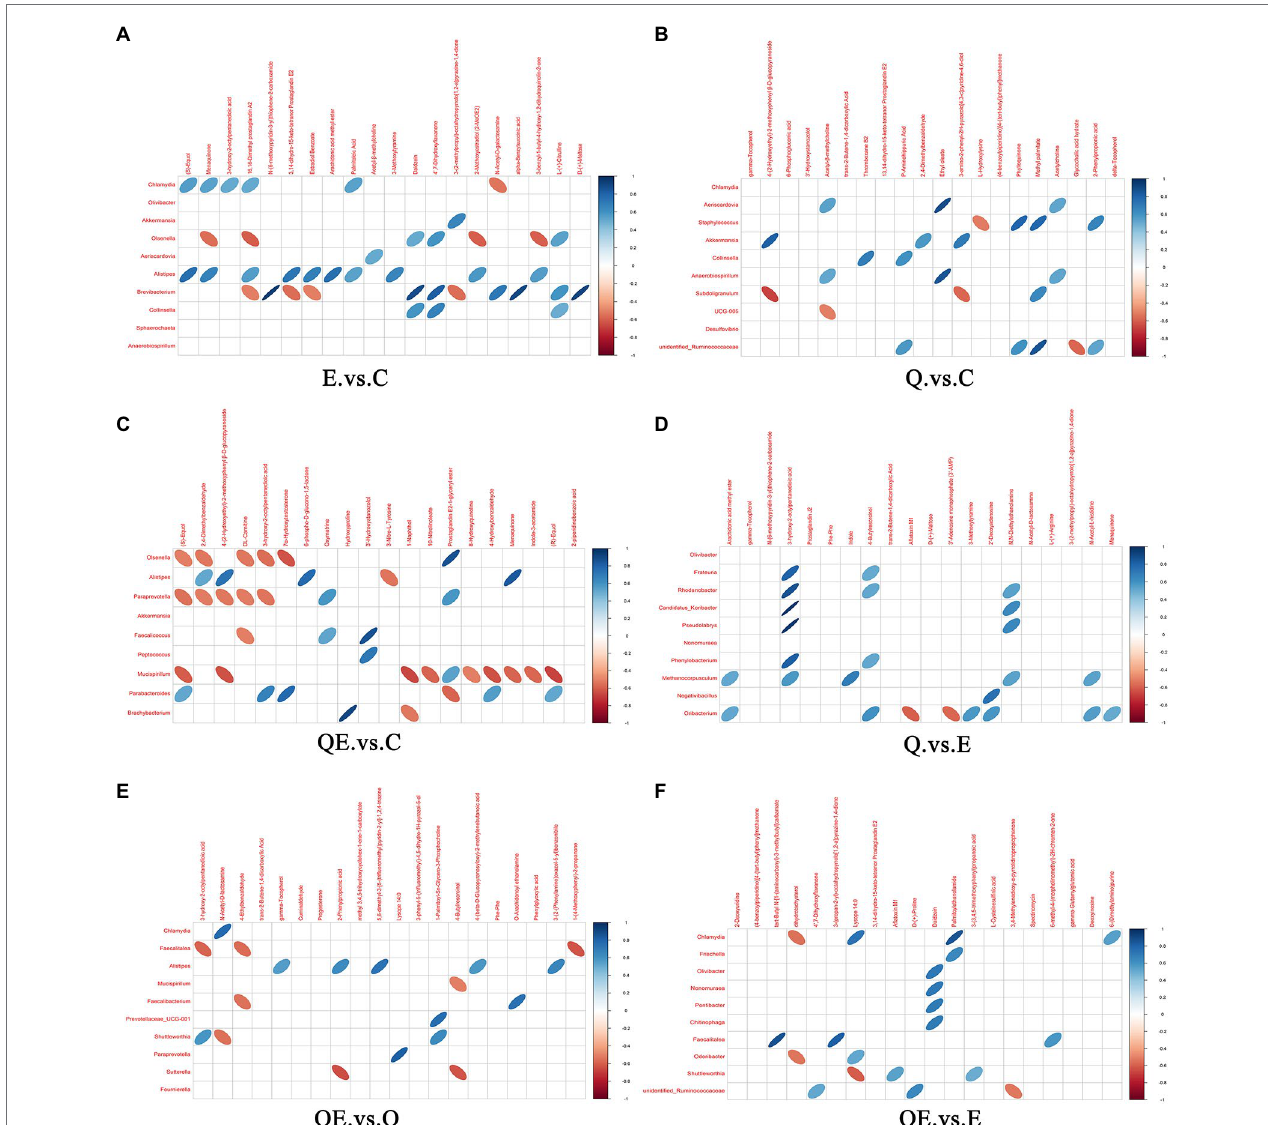
FIGURE 9 | Correlation between microbiota and metabolites in the cecum of aged breeder hens fed quercetin (Q) or vitamin E (E) or QE compared with the control group (C) in a pairwise comparison. (A) E_vs_C. (B) Q_vs_C. (C) QE_vs_C. (D) Q_vs_E. (E) QE_vs_Q. (F) QE_vs_E. The upper frame represents the negative ion mode, and the lower frame represent the positive ion mode. Blue means positive correlation, red means negative correlation, and blank means not statistically significant ( p > 0.05). Intersection of microbiota and metabolites with oval shape object indicates significant correlation coefficient ( p < 0.05) and those with no oval object (shape) indicate no significant correlation ( p >